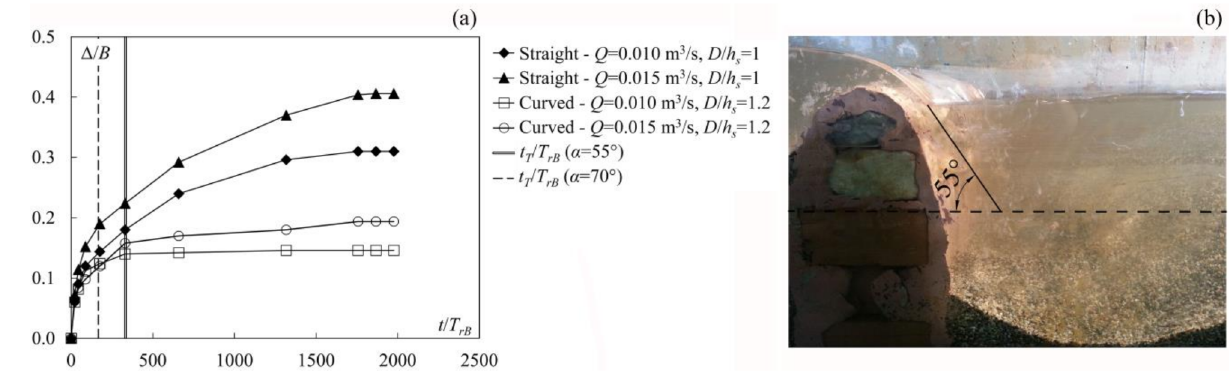
Figure 5. ( a ) ∆ / B versus t / T rB for straight and curved rock sills (Palermo and Pagliara, [27]), along with vertical lines indicating the transition time calculated using Equation (3) with α = 55 ◦ and 70 ◦ . ( b ) Picture of a test conducted with a straight rock sill ( Q = 0.010 m 3